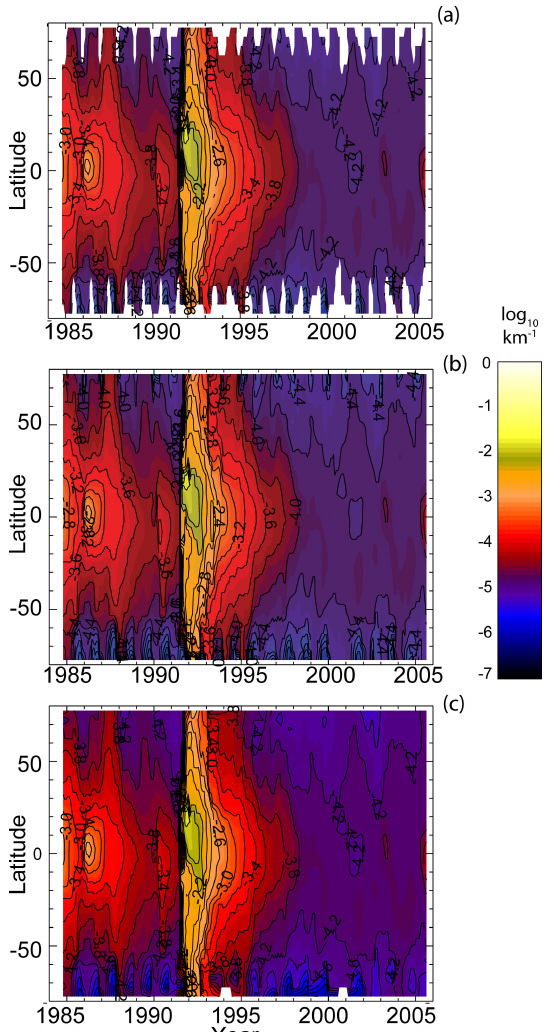
Figure 11. GloSSAC analysis prior to using the equivalent latitude filling process (a) and afterwards (b) . (c) Shows the use of brute temporal interpolation to fill high latitudes.